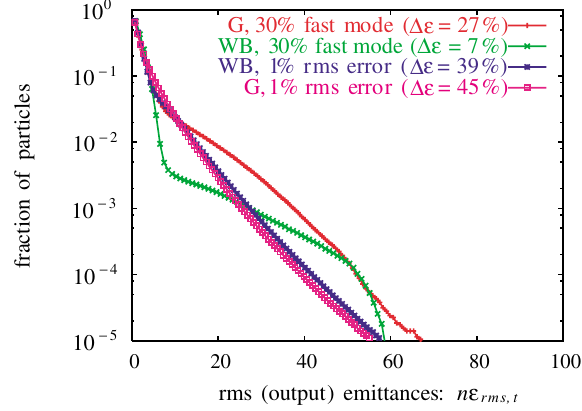
FIG. 15. (Color) Averaged fraction of particles exceeding n" for statistical error runs normalized to the final rms rms ;t emittance of each case. 500 simulations, 6D Gauss/waterbag, 200 focusing periods, and (cid:25) " ! rms emittance